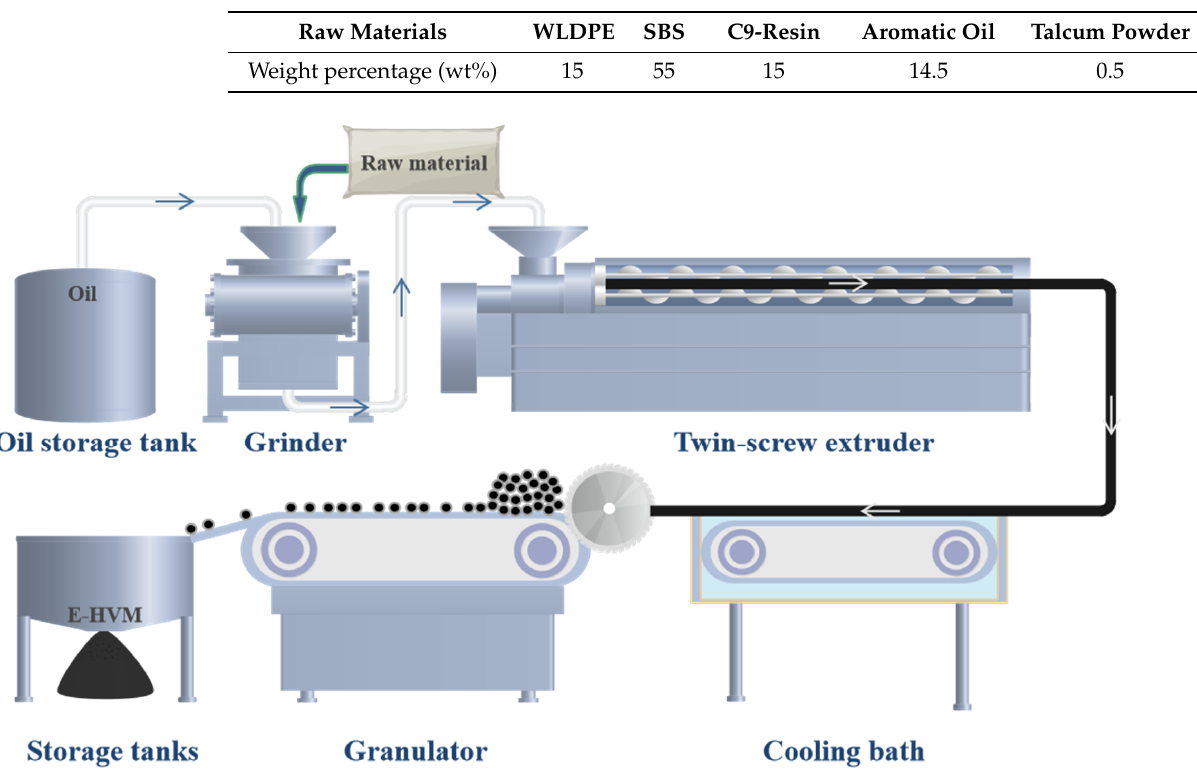
Table 3. Material composition of E-HVM.